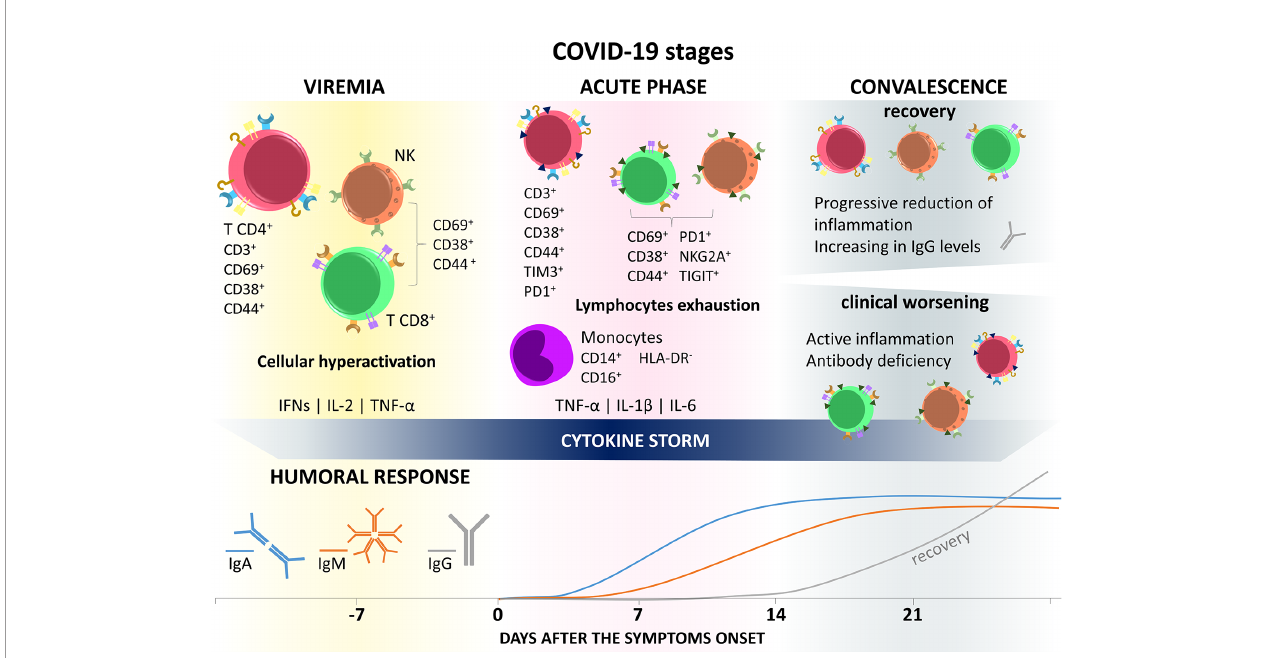
FIGURE 2 | Immune response in COVID-19 stages. SARS-CoV-2 infection is divided into three general phases. In the fi rst one, called viremia, the virus spreads through the body and there is excessive activation of immune cells with exacerbated production of in fl ammatory mediators, such as IFN- g , IL-2, and TNF- a , triggering cytokine storms and immune impairment. The second (acute) phase, characterized by the appearance of COVID-19 symptoms, presents a pro fi le of immune cells still hyperactivated, but with the presence of cell exhaustion markers, such as Tim3, PD1, TIGIT, and NKG2A, in addition to losing the functional capacity of producign IFN, IL-2, and TNF- a . In this period there is still the appearance of CD14 + CD16 + hyperin fl ammatory monocytes, with a high production capacity of TNF- a , IL-1 b , and IL-6, which will migrate to the lungs, contributing to the pathogenesis of respiratory failure and maintaining the cytokine storm. The lethargic state of the immune system in the early stages of infection may be related to the delay in the generation of a humoral response. In the third, or convalescence, phase, the individual can evolve in two opposite directions, recovery or clinical worsening/death. In recovery, cells of lymphoid origin recover their effector function and lose markers of exhaustion, while IgG levels improve. On the other hand, in patients with clinical worsening, this status of immune anergy